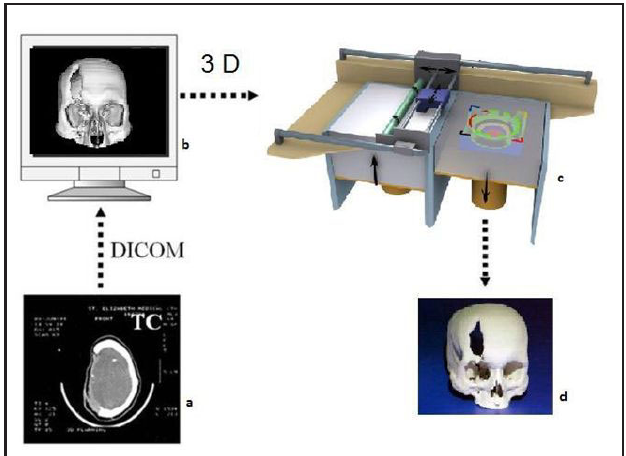
Fig. 1. Processing steps of acquiring biomodels: a) CT is performed on a DICOM format with less than 1 mm slices, b) specific software is used to generate 3D images, c) the file is transferred to prototyping machine and, d) the biomodel is produced.